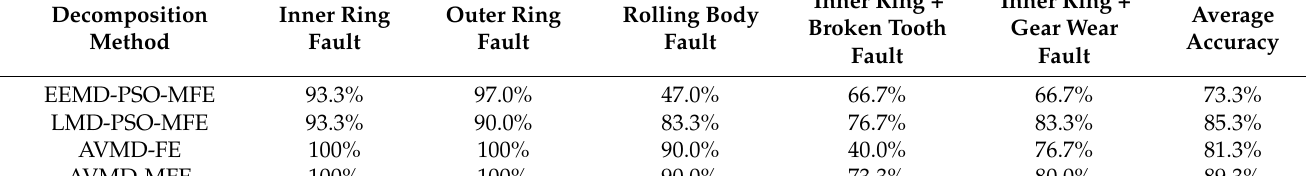
Figure 7. T-SNE dimensional reduction visualization of MFE feature set. ( a ) EEMD-PSO-MFE fea-